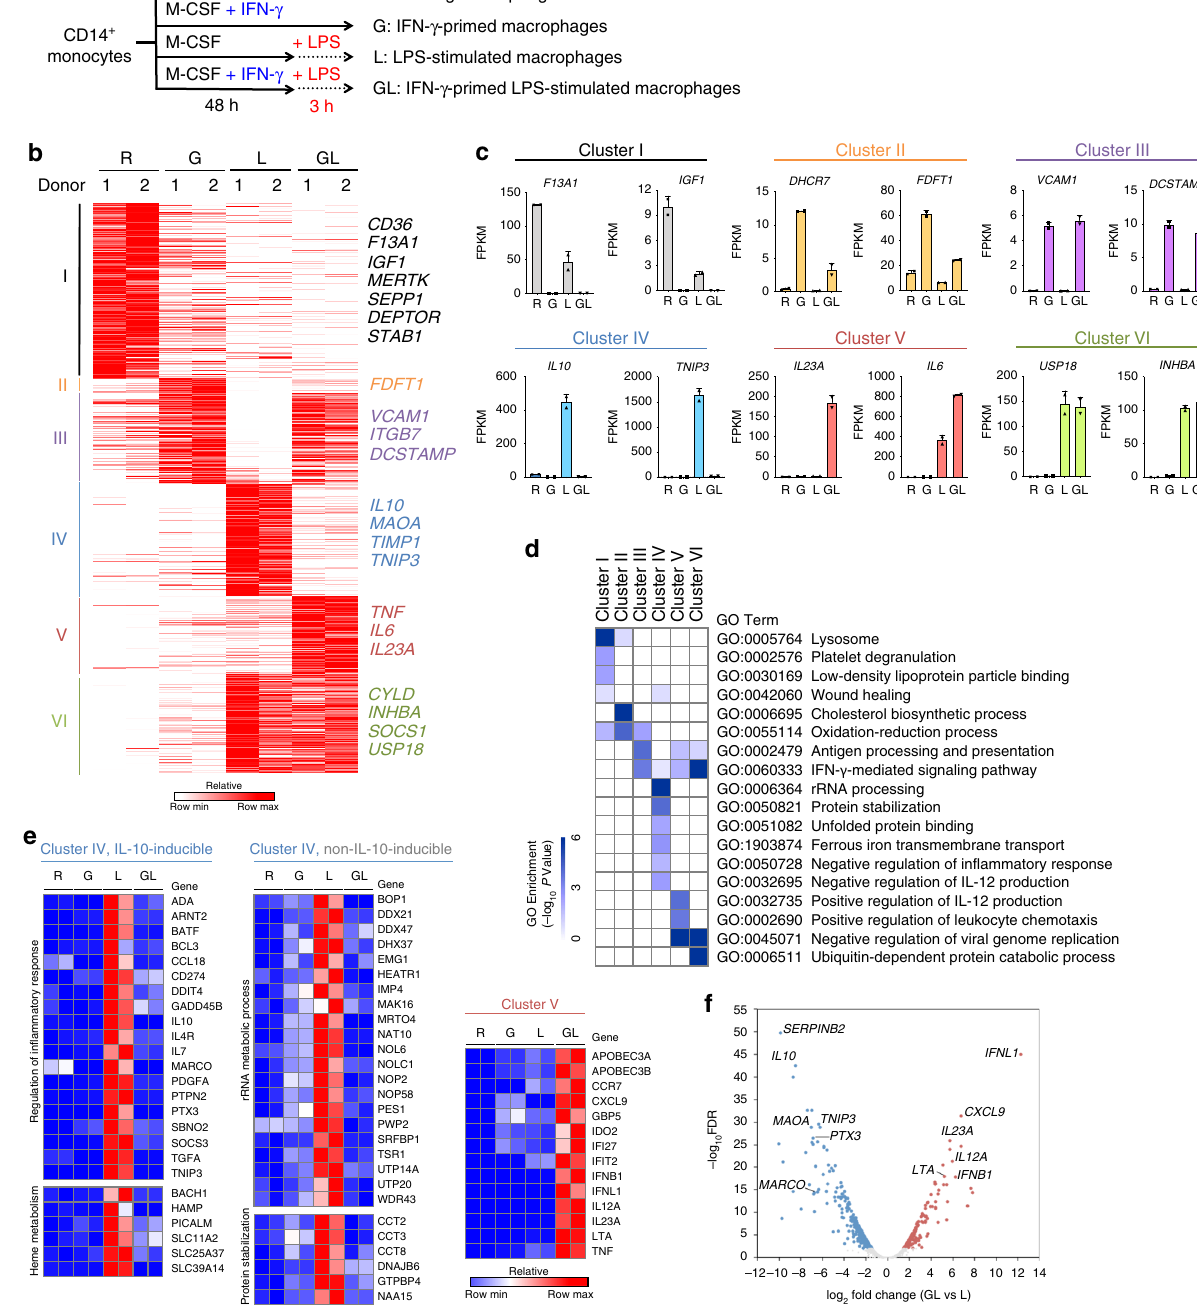
Fig. 1 IFN- γ -mediated reprogramming of TLR4-induced transcriptome in human macrophages. a Experimental design: human CD14 + monocyte-derived macrophages underwent one of four different combinations of priming for 48 h with IFN- γ before stimulation with LPS (or not) for 3 h: without priming or stimulation (R); primed with IFN- γ without LPS stimulation (G); LPS stimulation only with no priming (L); or primed with IFN- γ and stimulated with LPS (GL). b K-means (K = 6) clustering of 3,909 differentially expressed genes in any pairwise comparison among four conditions. Clusters are indicated on the left. c Examples of expression of select genes from the six clusters identi fi ed in a . Each dot in the bar plot represents one donor and error bars represent standard deviation. d Heatmap showing the P -value signi fi cance of GO term enrichment for genes in each cluster. e Heatmap showing the relative expression of representative cluster IV genes that are inducible by IL-10 (left), cluster IV genes that are not inducible by IL-10 (middle), and cluster V genes. Distinct biological functions are indicated on the left. IL-10-inducible genes were obtained from GSE43700. f Volcano plot of transcriptomic changes between LPS (L) and IFN- γ -primed LPS-stimulated (GL) macrophages; colored dots correspond to genes with signi fi cant (FDR < 0.01) and greater than two-fold expression changes. Data from two independent experiments with different donors are